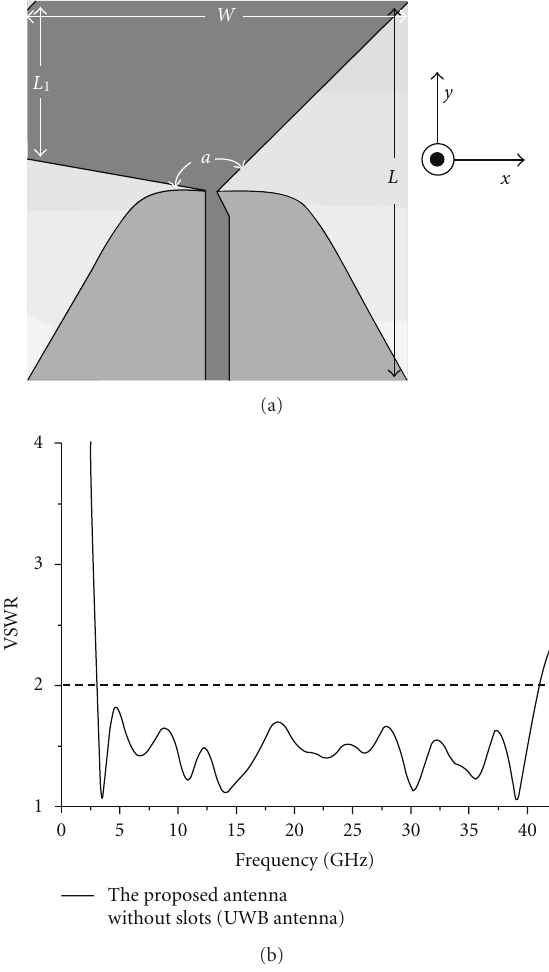
Figure 1: The geometry and the simulated VSWR result of the proposed antenna without slots (UWB antenna): (a) the geometry, (b) the simulated VSWR